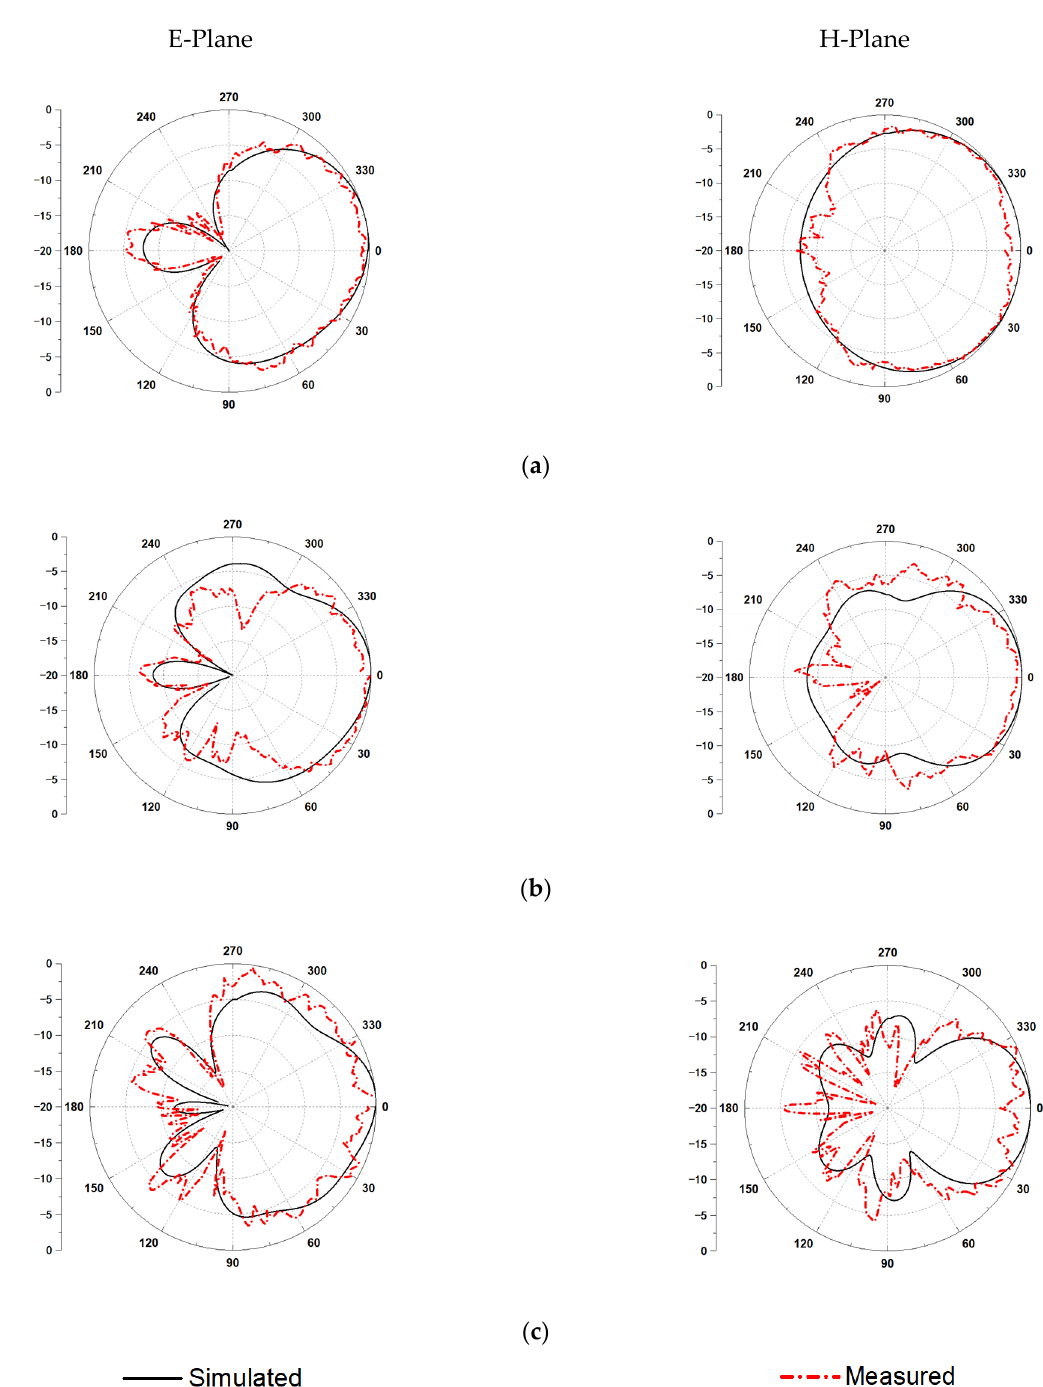
Figure 9. Simulated and measured radiation patterns of E-plane and H-plane: ( a ) 3 GHz, ( b ) 5 GHz, and ( c ) 7 GHz.